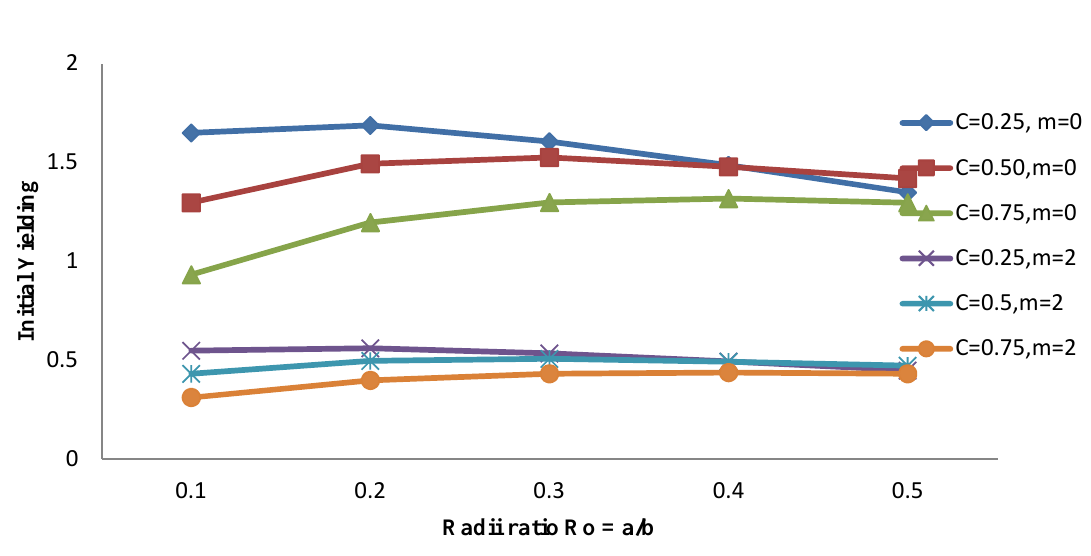
=a / b in rotating shell (cid:20)